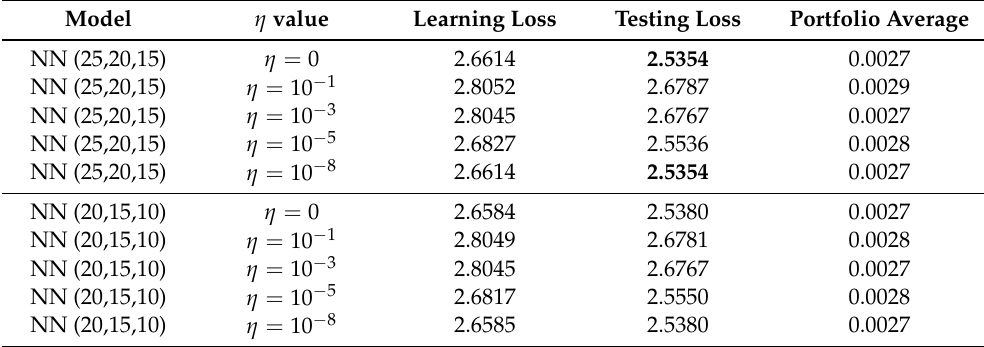
Table 5. Testing loss, learning loss, and portfolio average of the Poisson neural network models ((20,15,10), and (25,20,15) architectures) with regularisation ( η = 10 − 1 , η = 10 − 3 , η = 10 − 5 , η = 10 − 8 ), and without regularisation ( η = 0). Model η value Learning Loss Testing Loss Portfolio Average NN